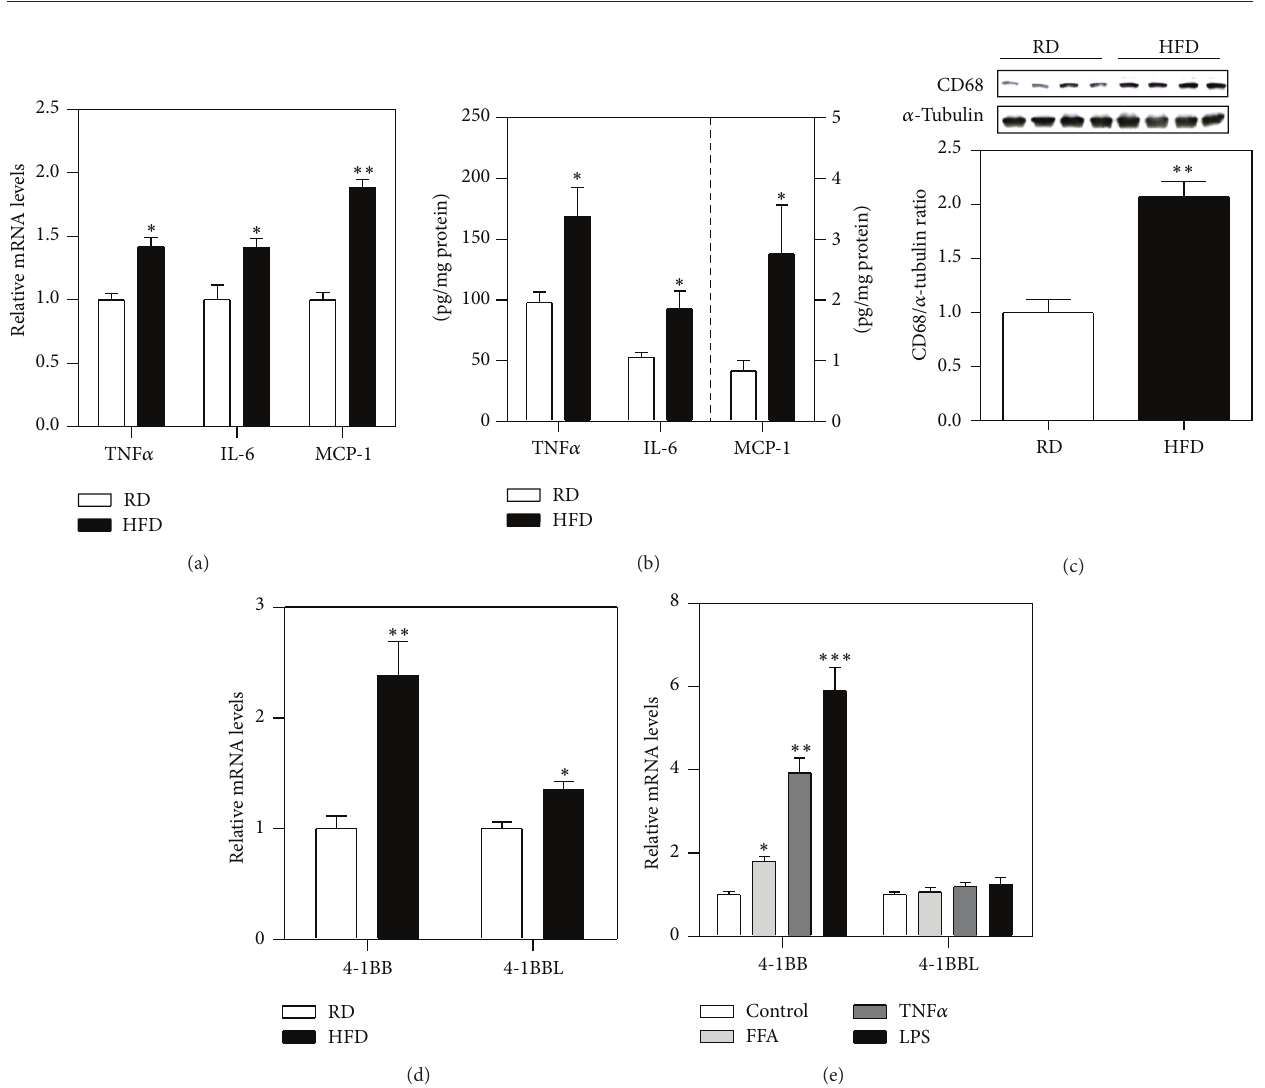
Figure 1: Levels of 4-1BB/4-1BBL mRNAs and inflammatory markers in obese skeletal muscle. C57BL/6 mice were fed a regular diet (RD) or high-fat diet (HFD) for 9 weeks. ((a) and (b)) TNF 𝛼 , IL-6, and MCP-1 mRNAs and proteins were measured by qRT-PCR and